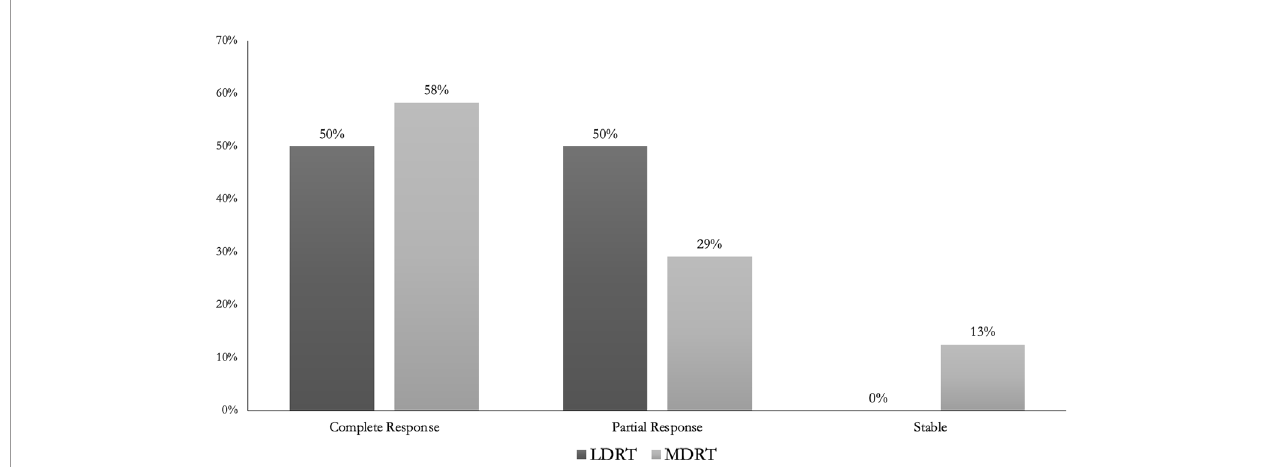
FIGURE 4 | Overall Response Rates for patients with indolent orbital adnexal lymphomas treated with low-dose radiotherapy (LDRT) compared to patients treated with moderate-dose radiotherapy (MDRT).